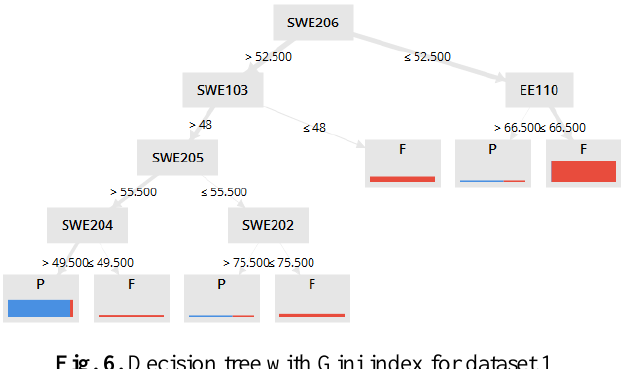
Fig. 6. Decision tree with Gini index for dataset 1